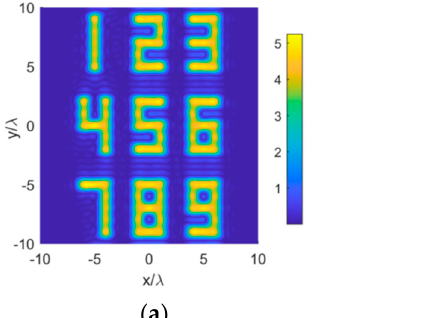
Figure 4. The reconstructed pictures of the four sources: ( a ) Case 1; ( b ) Case 2; ( c ) Case 3; ( d ) Case 4.